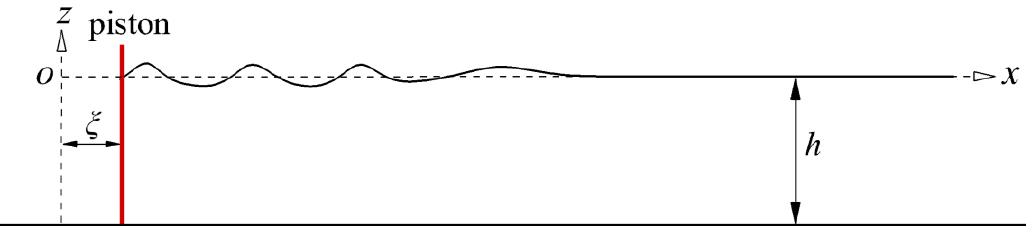
Figure 1. An illustration of a piston-type wave maker.